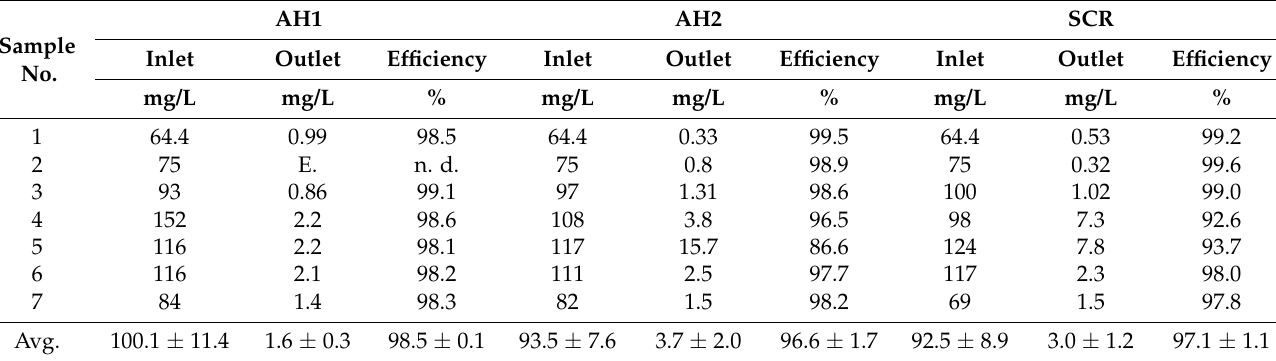
Table 6. Inlet and outlet N NH4 and removal efficiencies at stage